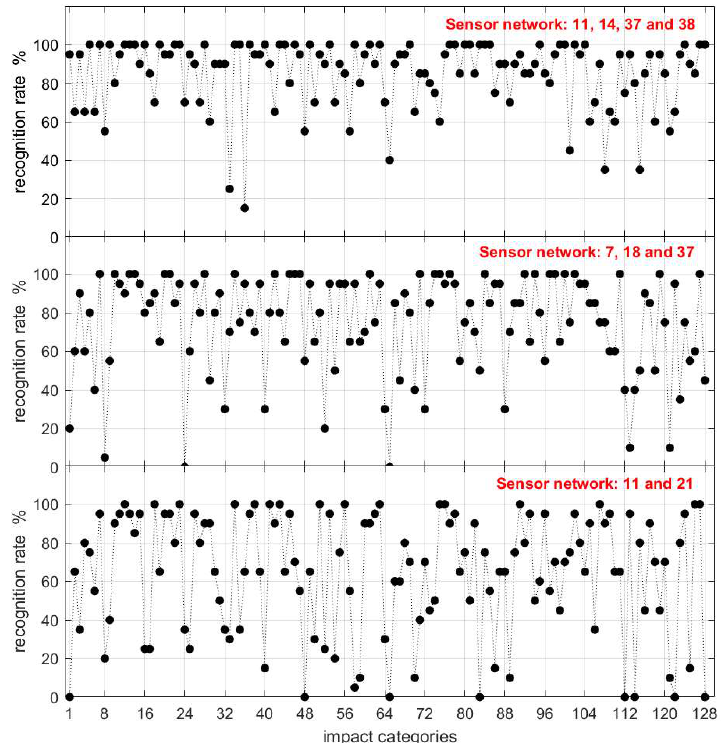
Figure 7. Impact recognition rate with different numbers of sensors. Table 6. Impact recognition rate of different sensor networks.